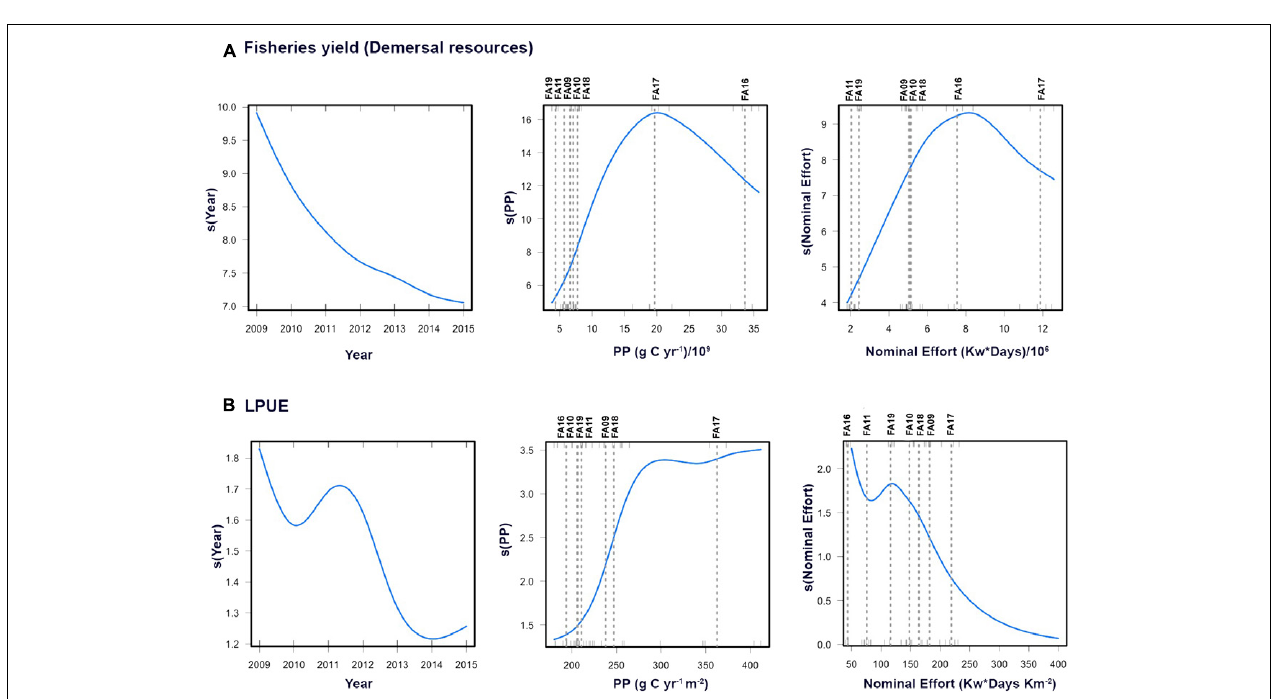
FIGURE 11 | Effects of the different predictors (if significant), independent of the other predictors, are represented as response variable shape for each species. The degree of smoothing is indicated in the y -axis label. Confidence intervals (95%) around the response curve are represented by dashed lines.